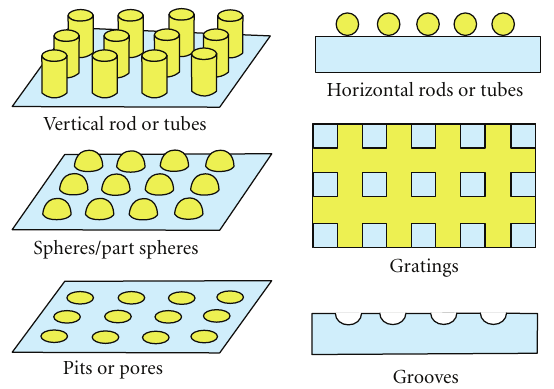
Figure 2: Some typical topographical surface